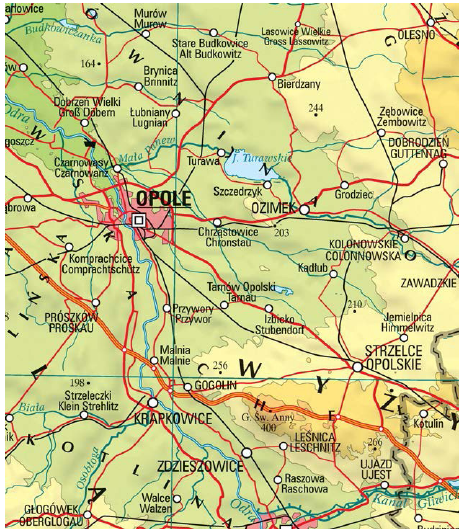
Fig. 7. Part of a map of Poland with